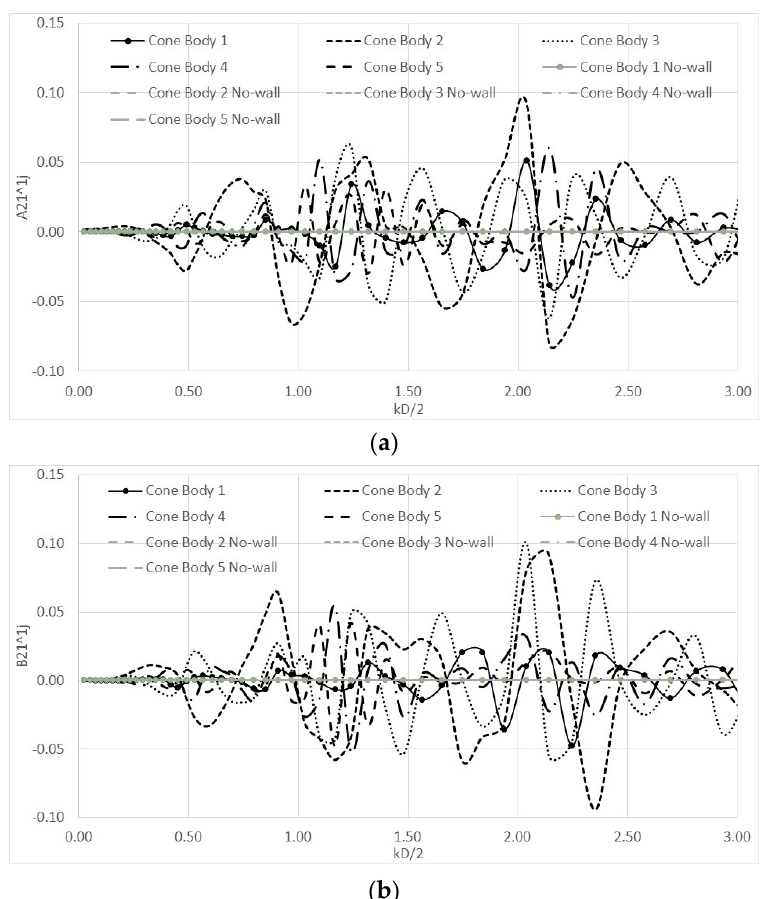
Figure 23. Dimensionless added mass ( a ) and damping coefficient ( b ) of the 1st conical floater in the sway direction due to the forced motion in surge of the j- th conical floater ( j = 1, 2, …, 5) against kD/2, for the parallel arrangement, C 1 .